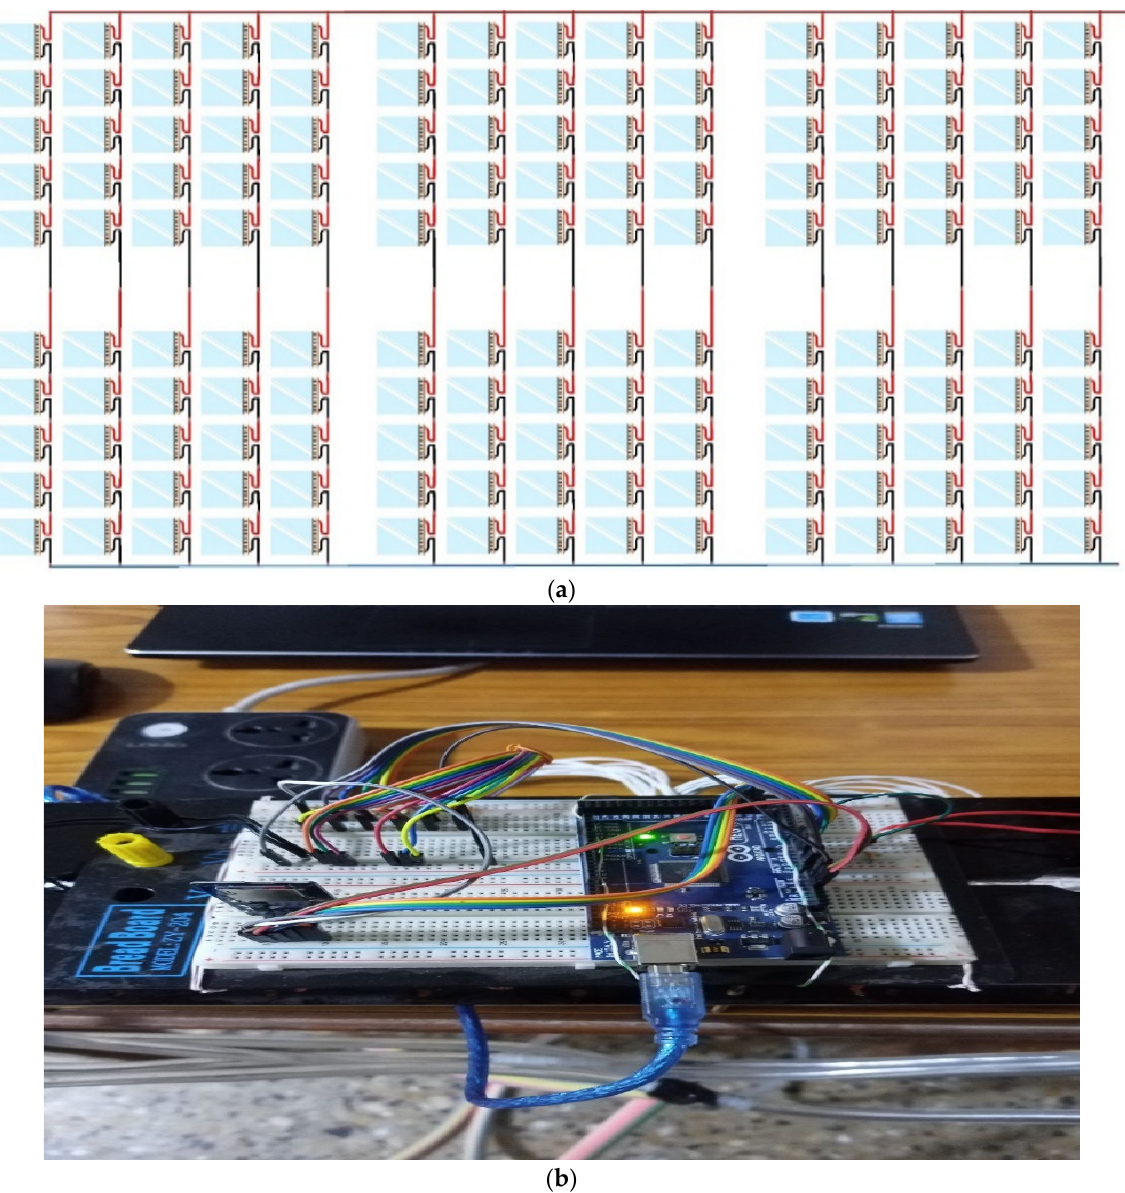
Figure 8. ( a ) Electrical connections of the panel board in parallel and series, and ( b ) Electrical connections of a microcontroller (Mega).